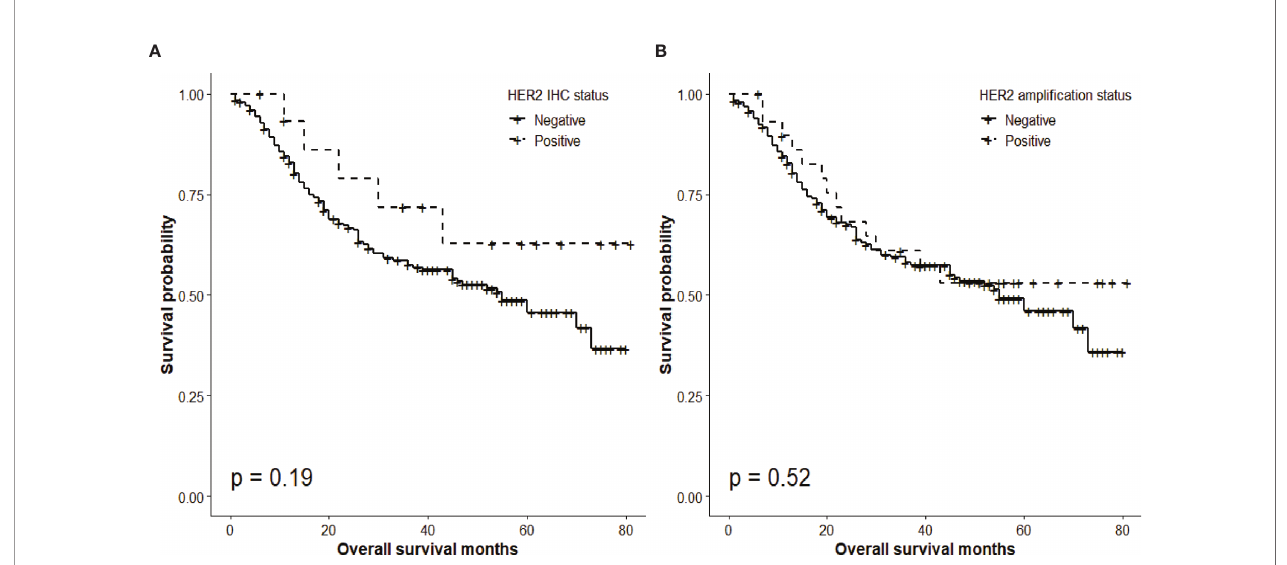
FIGURE 3 | Overall survival according to HER2 status. (A) Absence of signi fi cant differences in overall 5-year survival rate according to HER2 IHC status (HER2 IHC 3+ tumors, 62.8%; HER2-negative (0, 1, 2+) tumors, 45.6%; P = 0.19). (B) Absence of signi fi cant differences in 5-year survival rate according to HER2 ampli fi cation status (HER2 SISH+, 53.1%; HER2 SISH − , 45.9%; P =